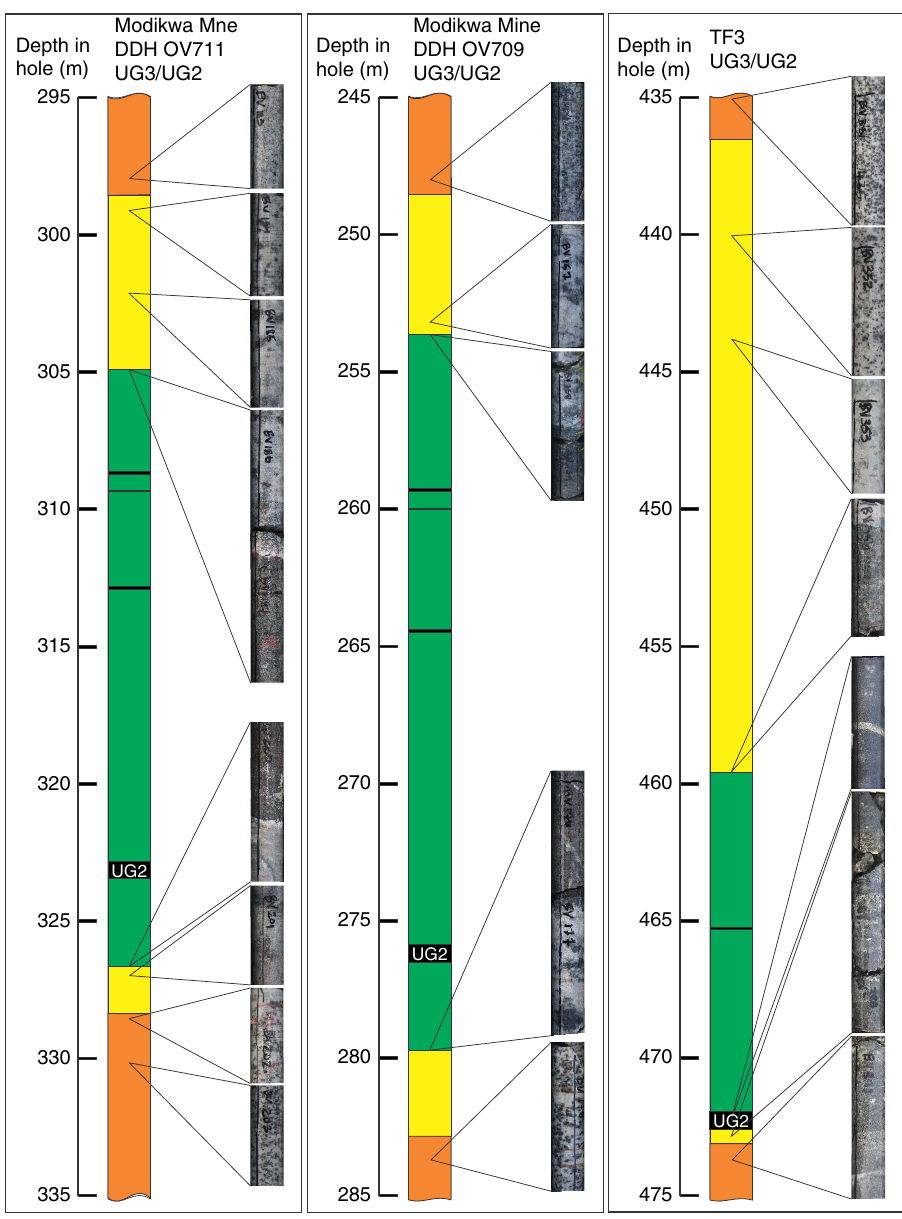
Figure 3 | Schematic sections and detailed core photographs of key intrusive contact textures. Contacts shown are tops and bottoms of the composite UG2/UG3 Unit, at the Modikwa Mine in the Central sector of the eastern Bushveld, and in the TF3 drill hole. At Modikwa Mine both upper and lower contacts of the UG2/UG3 Unit are sharp, separating ultramafic rock (green) from anorthosite (yellow) which grades up or down into undisturbed norite (brown); at TF3 the upper contact is sharp against anorthosite but the lower contact is occupied by mafic